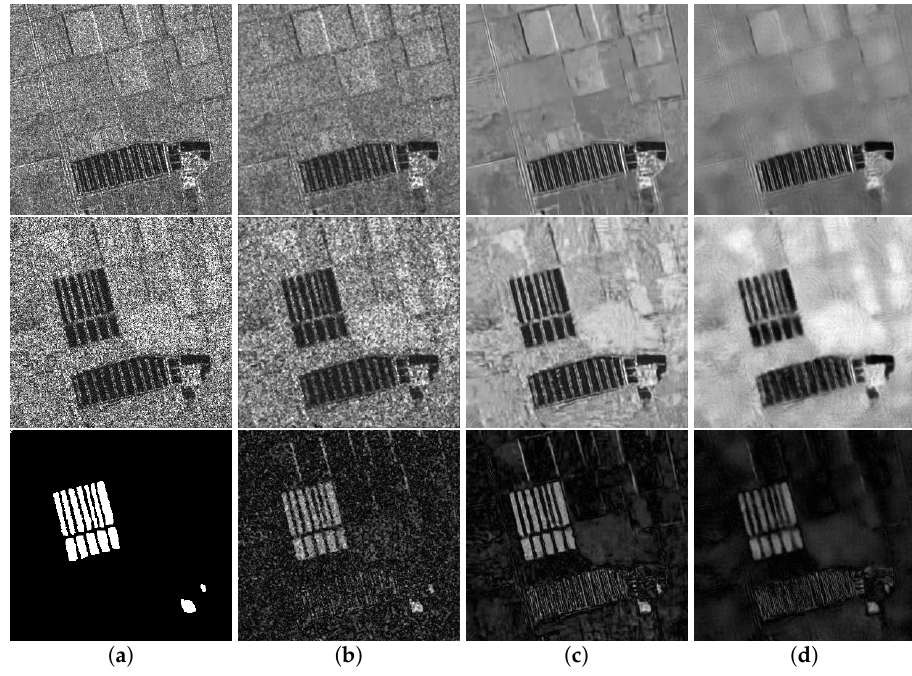
Figure 4. The Yellow River Set B. ( a ) Raw images from June 2008 and June 2009 and reference map. ( b – d ) Filter images by MMSE, SAR-BM3D, PPB, and the corresponding DIs.